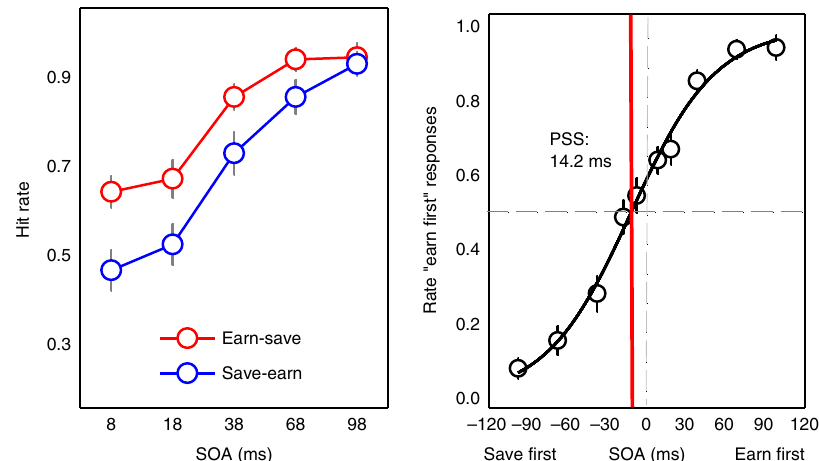
Fig. 5 Temporal-order judgment where earning and saving were de fi ned by temporal framing in Experiment 2. Left panel: the average hit rate for earn and save from the “ earn-save ” and “ save-earn ” trials as a function of stimulus-onset asynchrony (SOA). For the pairs in the trial, the fi rst stimulus name appeared earlier physically. Right panel: earn-save trials. Line is estimated point of subjective simultaneity (PSS) with leftward shift revealing save colors are judged to appear